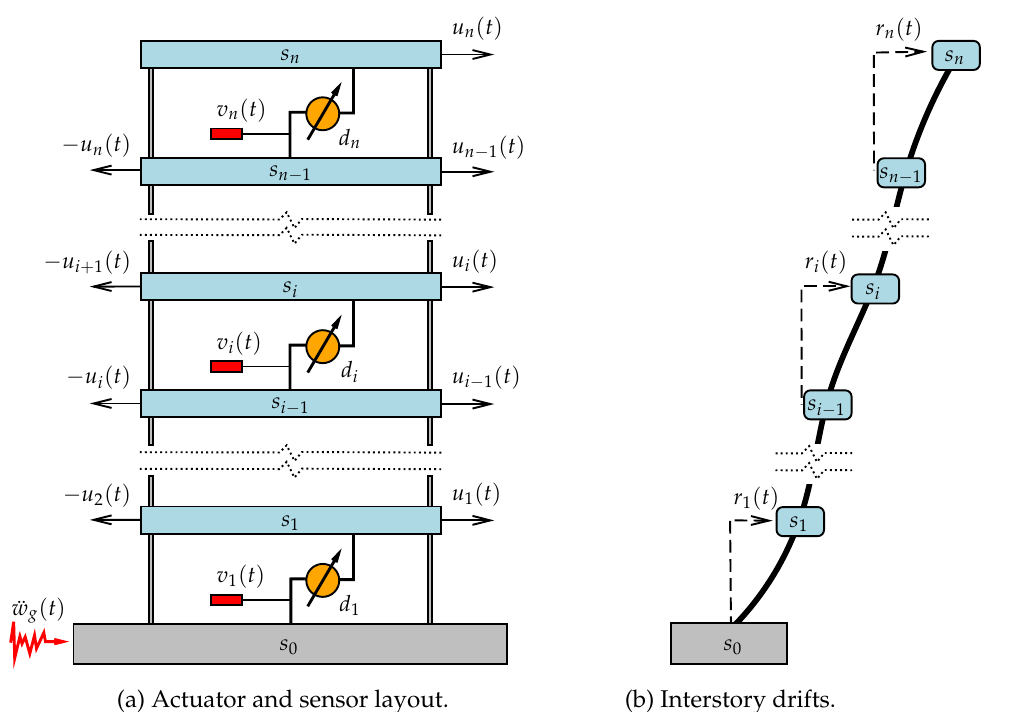
Figure 3. Multistory building equipped with a complete set of ideal interstory force-actuation devices and collocated interstory-velocity